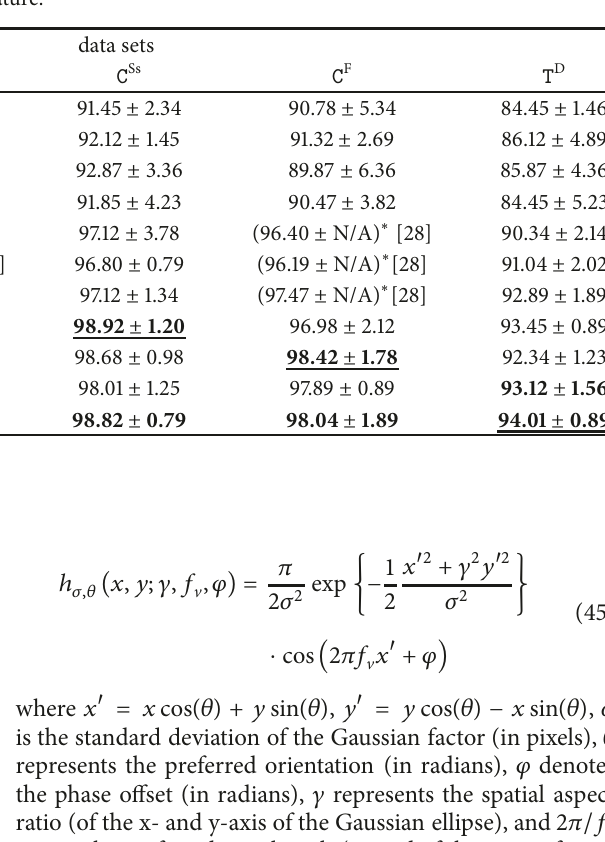
Table 4: Classification accuraciesof comparative methods. Results marked with asterisk are directly taken from the literaturewith references and N/A means the corresponding index is absent in the referred